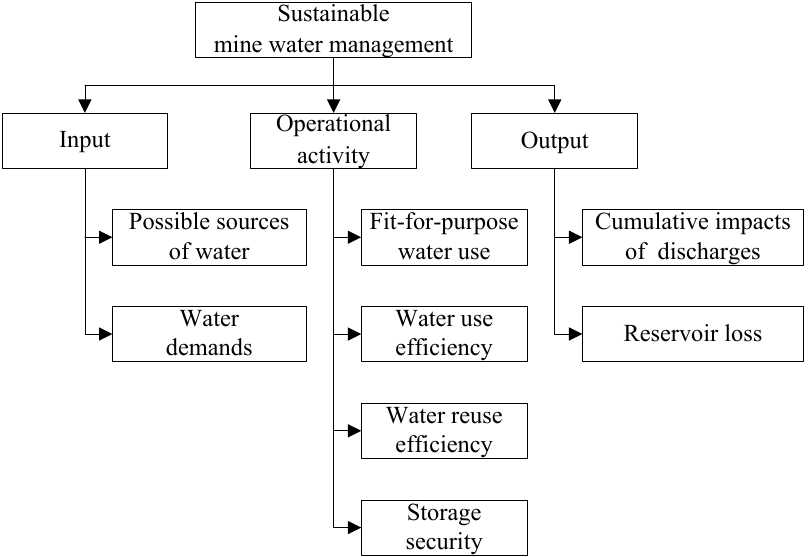
Figure 1. A conceptual framework for forming decision hierarchy for sustainable mine water